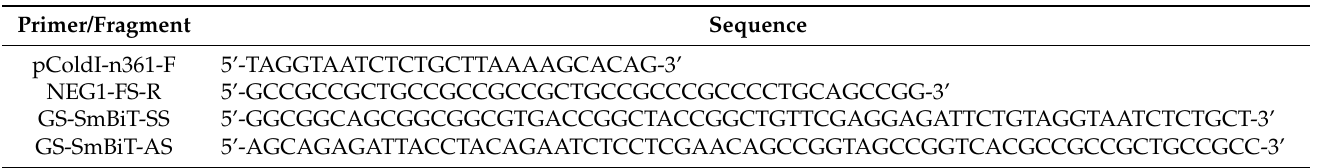
Table 2. DNA fragments used in this